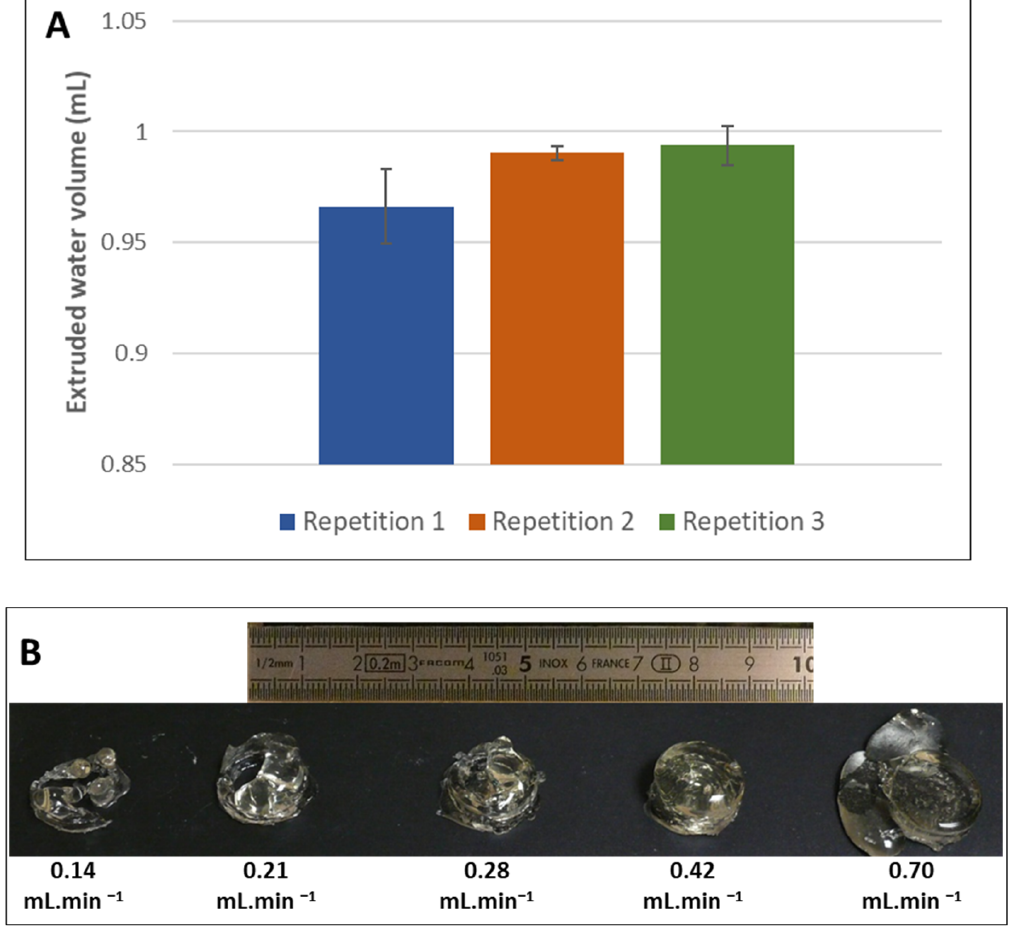
Figure 7. ( A ) Verification of the volume control delivered by the extruder at 60 °C. ( B ) Effect of flow rate on the geometry of the printed object.